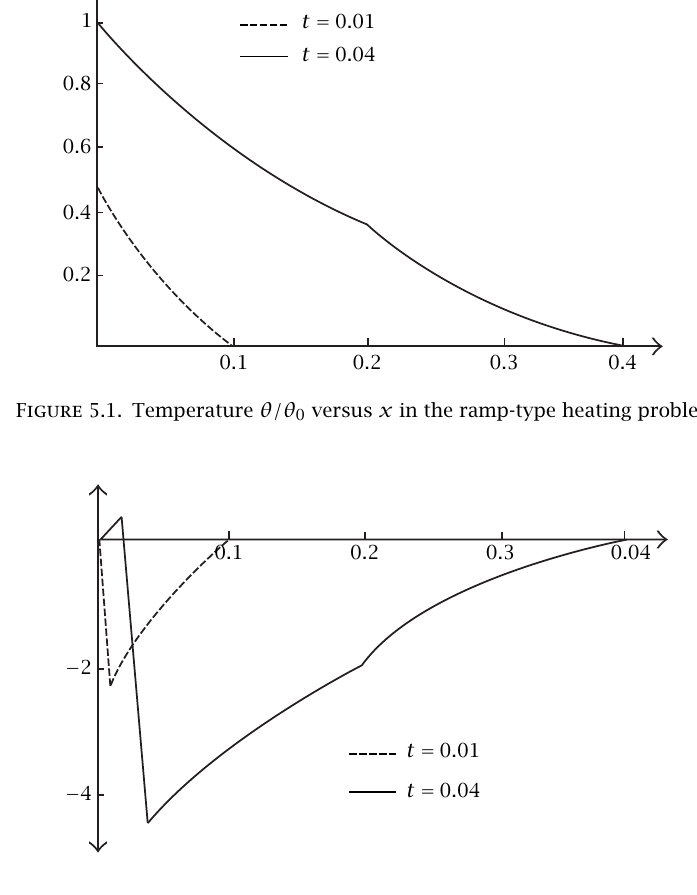
Figure 5.2 . Stress σ/θ 0 versus x in the ramp-type heating